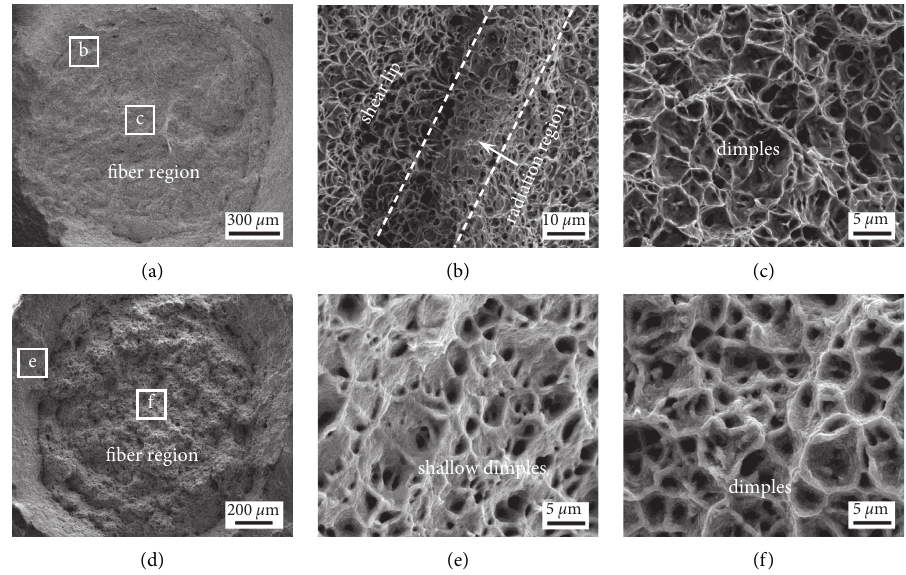
Figure 7: Fractography of the tensile test samples. (a, d) Macroscopic fractography; (b, c), (e, f) microscopic fractography; (a–c) ambient temperature tensile test fractography along X; (d–f) elevated temperature test fractography along